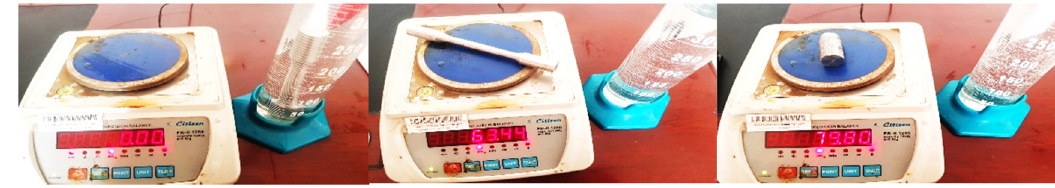
Figure 10: The Archimedes principle to determine the densities.